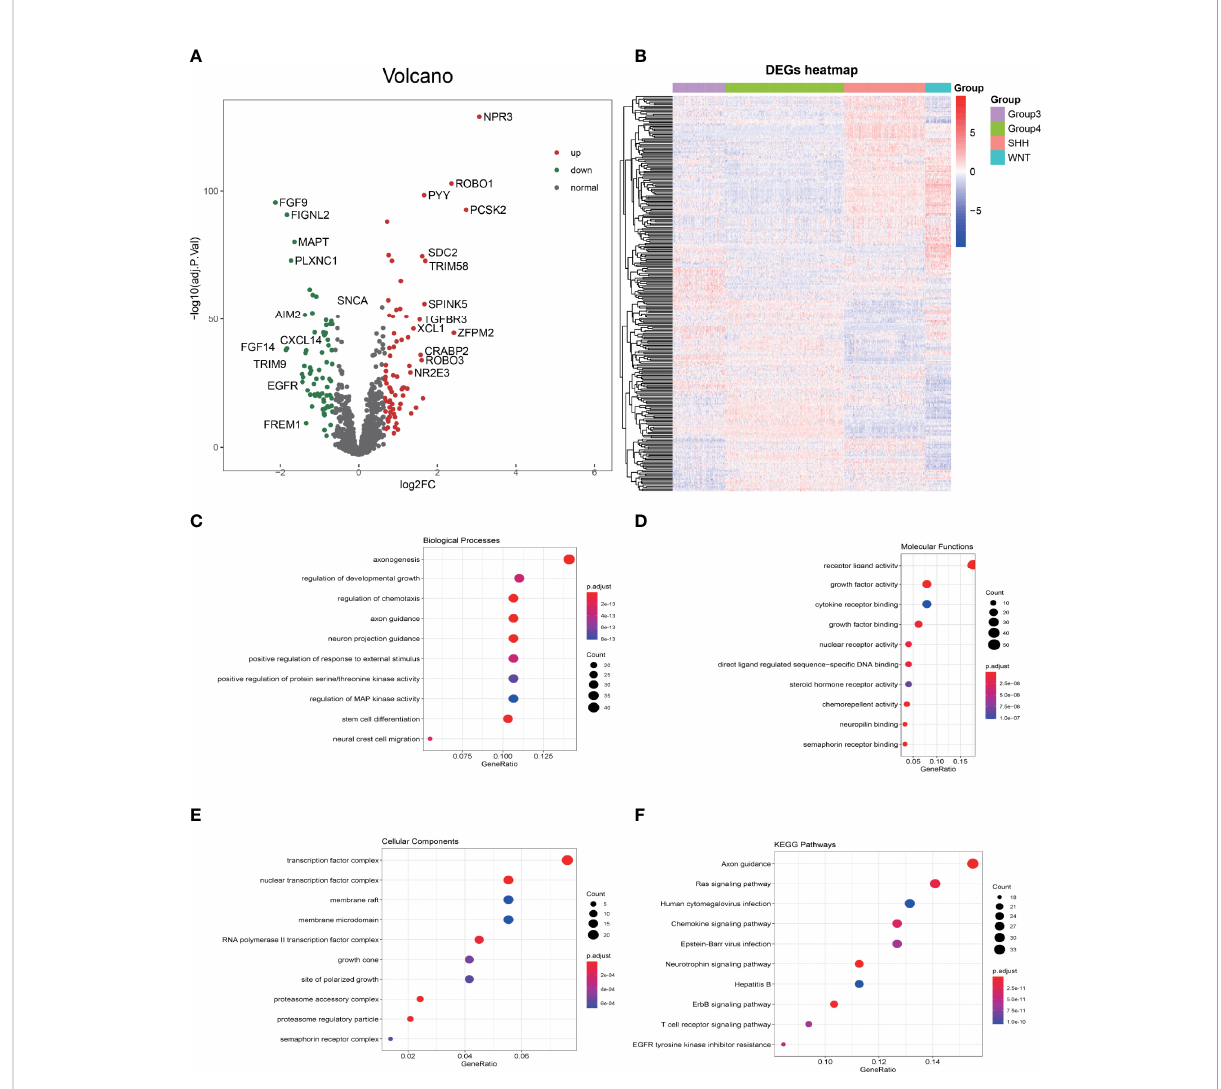
FIGURE 2 GO and KEGG enrichment analysis of differentially expressed immune genes (imm-DEGs). (A) The distribution of differentially expressed genes in group 3 vs . group 4 is depicted by the volcano plot. (B) The imm-DEGs clustered in the four subgroups of medulloblastoma. (C) Imm-DEGs were enriched in the biological processes. (D) Molecular functions of Gene Ontology. (E) Cellular components of Gene Ontology. (F) Kyoto Encyclopedia of Genes and Genomes (KEGG) enrichment analysis of